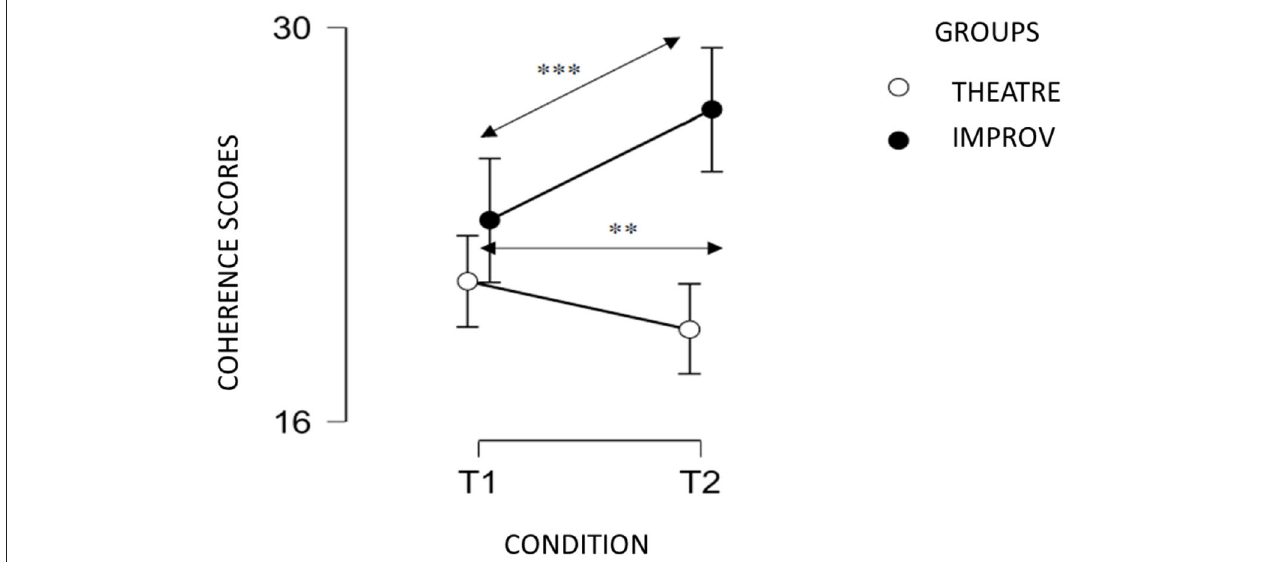
FIGURE 1 | Coherence scores at T1 and T2 for improv and theater groups. ** p < 0.01; *** p < 0.001.